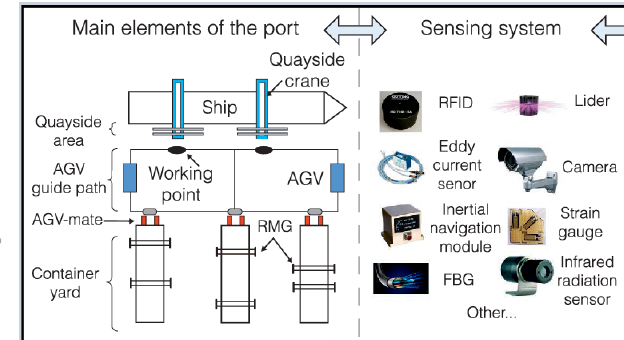
system model of ATOS [4].